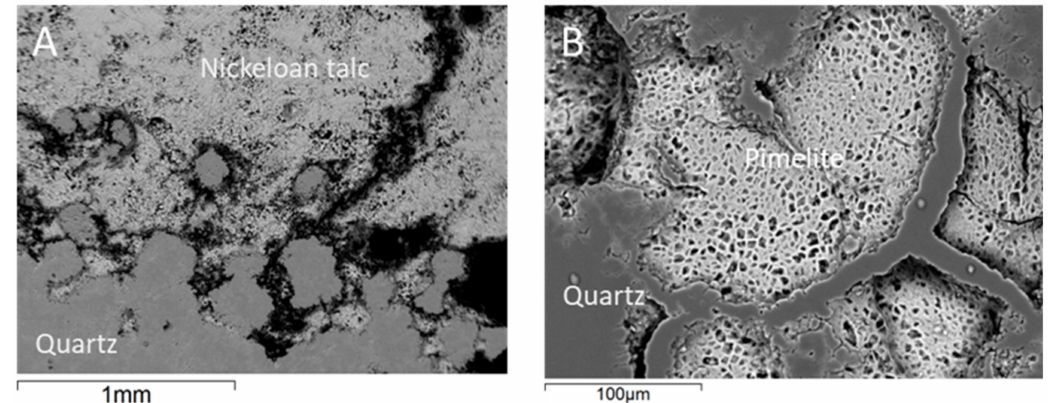
Figure 15. BSE images of silica nodules with ( A ) nickeloan talc and ( B )